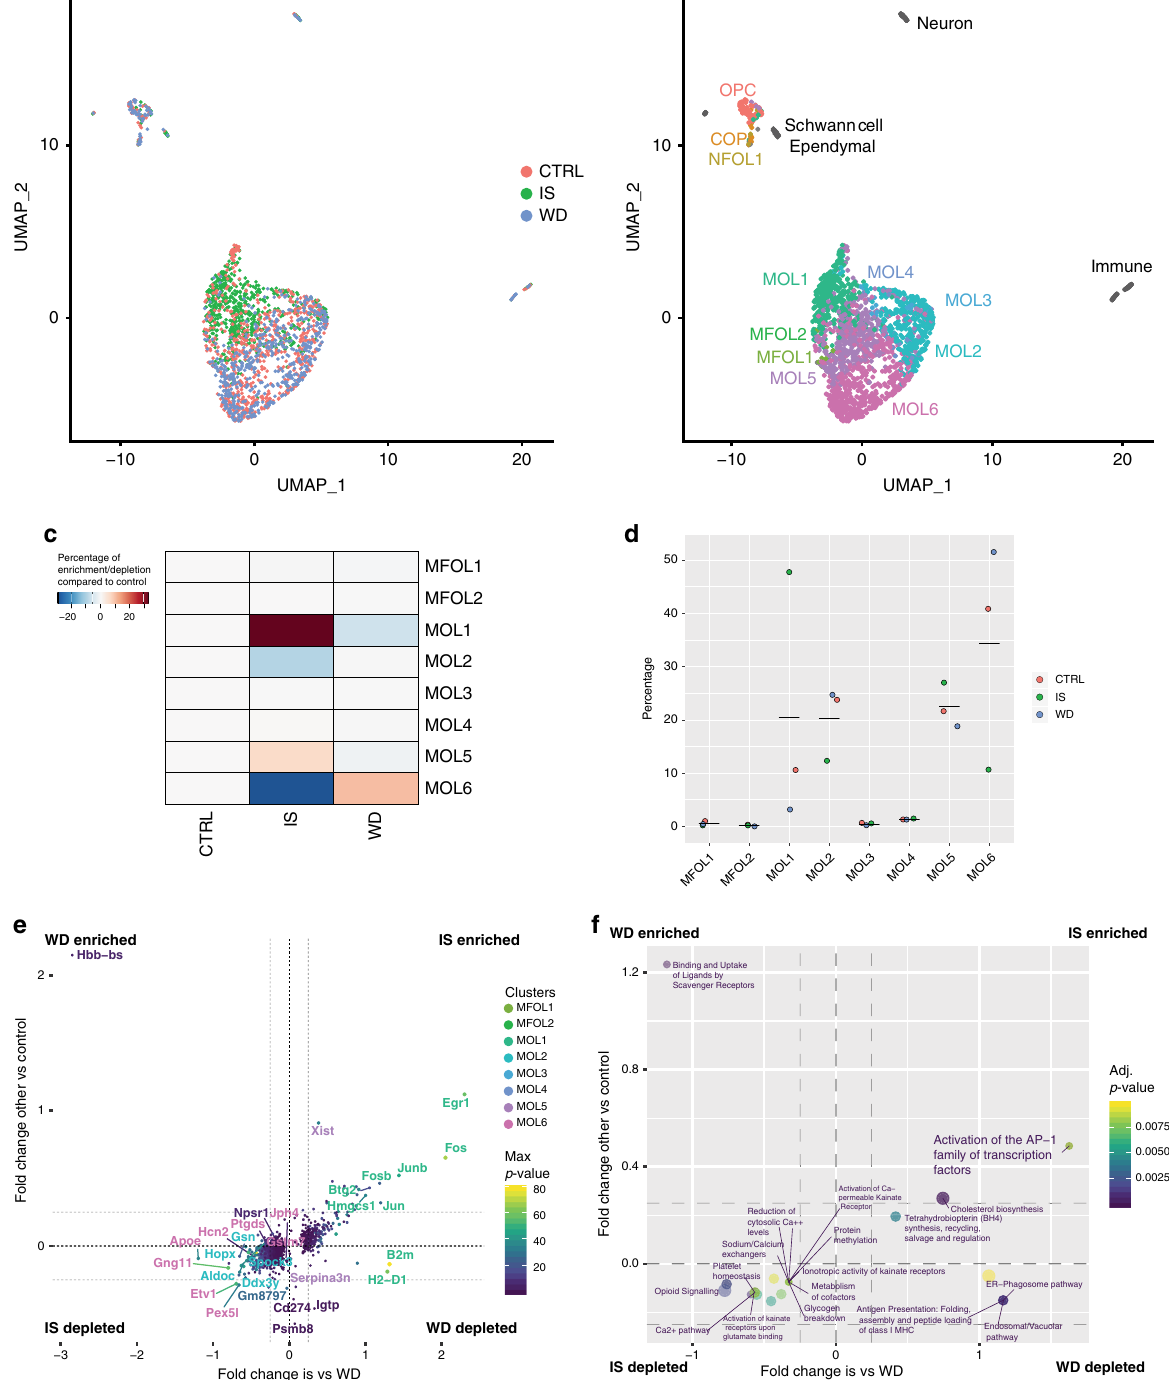
Antigen Presentation: Folding, assembly and peptide loading of class I MHC